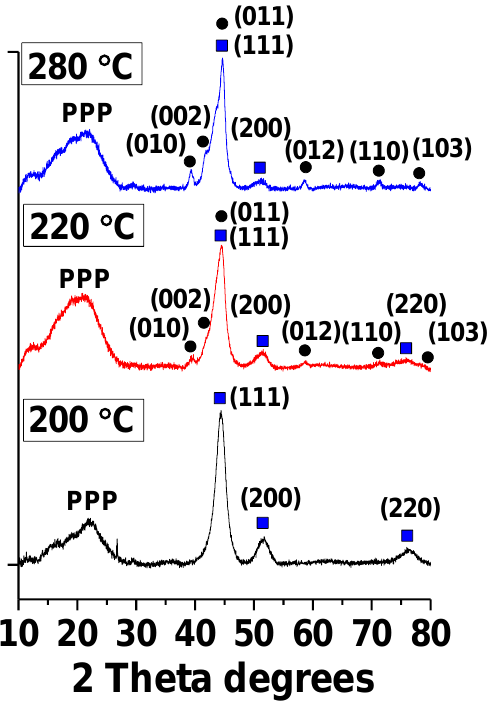
Figure 9. XRD patterns of Ni NPs prepared at 200 ◦ C, 220 ◦ C, 280 ◦ C by the “heat-up” approach. Squares are for the fcc phase, while circles indicate the hcp phase of Ni 0 . A broad peak at 2 θ ≈ 20 degrees corresponds to amorphous PPP.